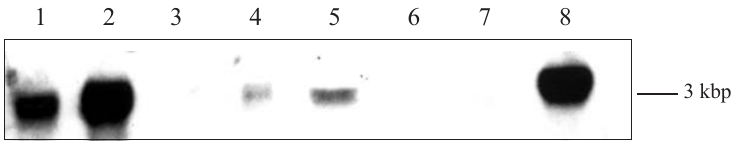
Fig. 2 – Expression pattern of the 3´-end of sequenceYE290 used as a probe in various tissues of potato plants. The transcript detected has a size of approximately 3.0 kbp. Total RNA was isolated from the following tissues: lane 1, androceum; lane 2, gyneceum; lane 3, coloured buds; lane 4, green buds; lane 5, epidermal fragments; lane 6, sink leaves; lane 7, source leaves; lane 8, roots. Amount of total RNA per lane about 30 µ